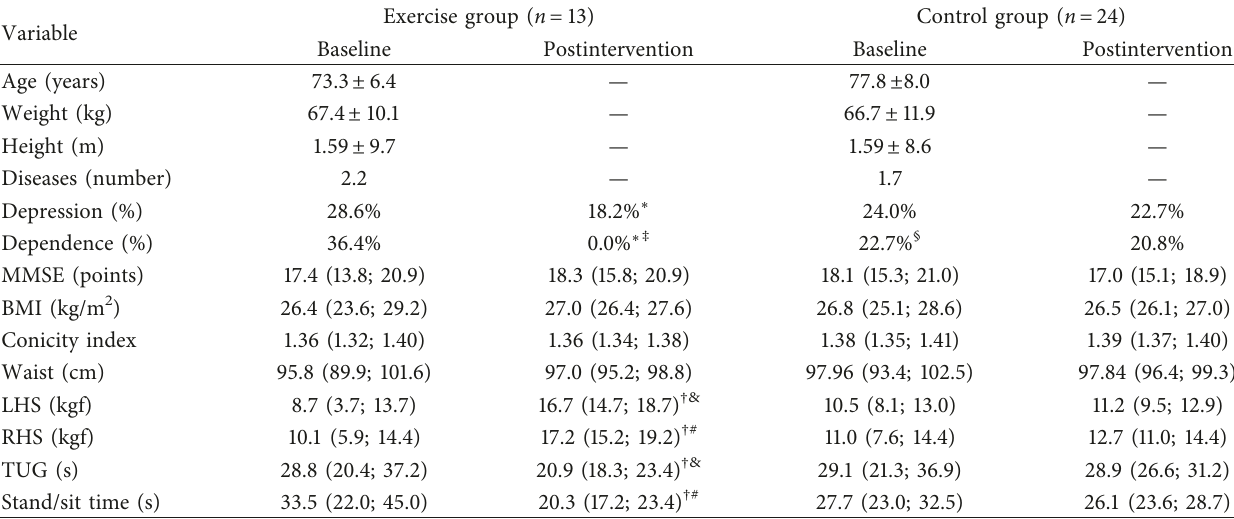
Table 2: Comparison of anthropometric, clinical, and functional performance variables between baseline and postintervention moments.